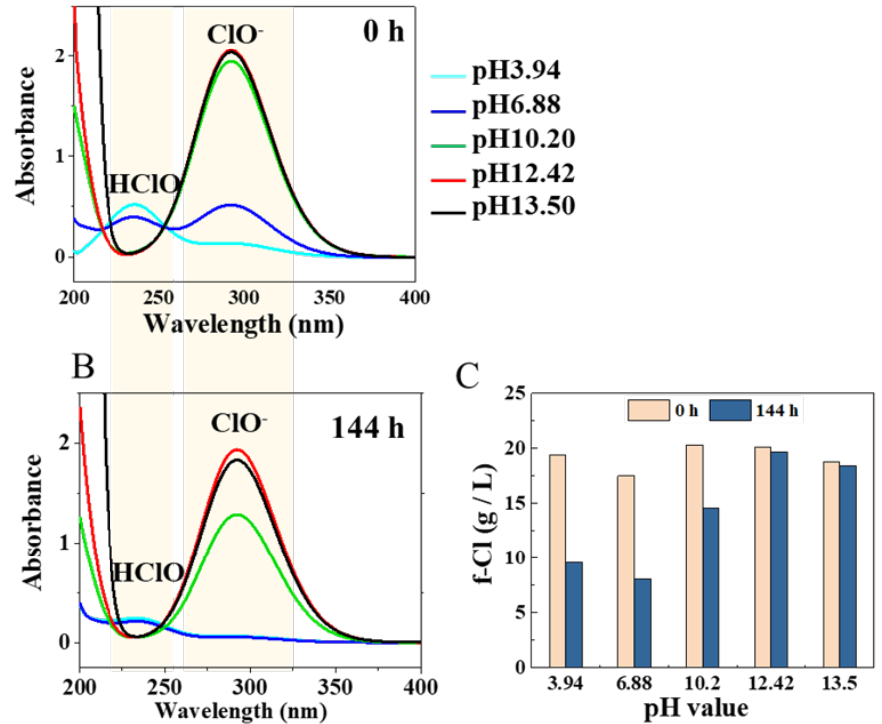
Figure 4. Optical absorbance spectra of NaClO solutions at different pH values at 0 h ( A ) and after 144 h ( B ) at 37 °C. ( C ) Free available chlorine (f-Cl) concentration in NaClO solutions at different pH values at 0 h and after 144 h.